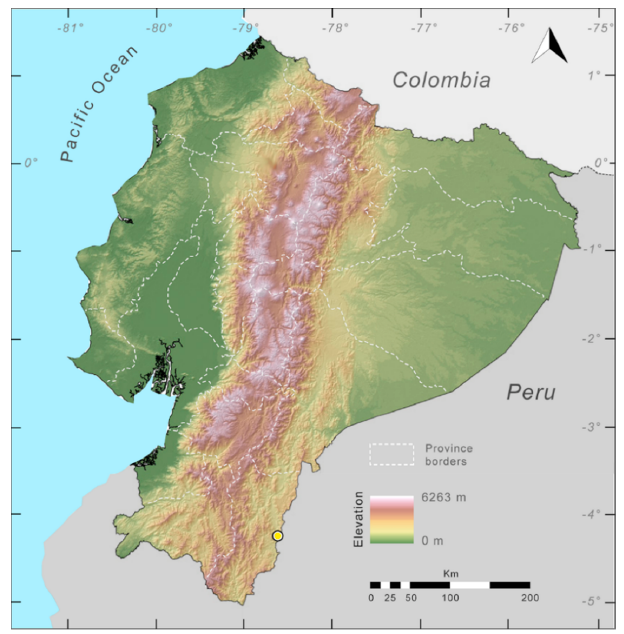
Figure 147. Distribution of Nymphargus colomai sp. nov. in Ecuador (yellow